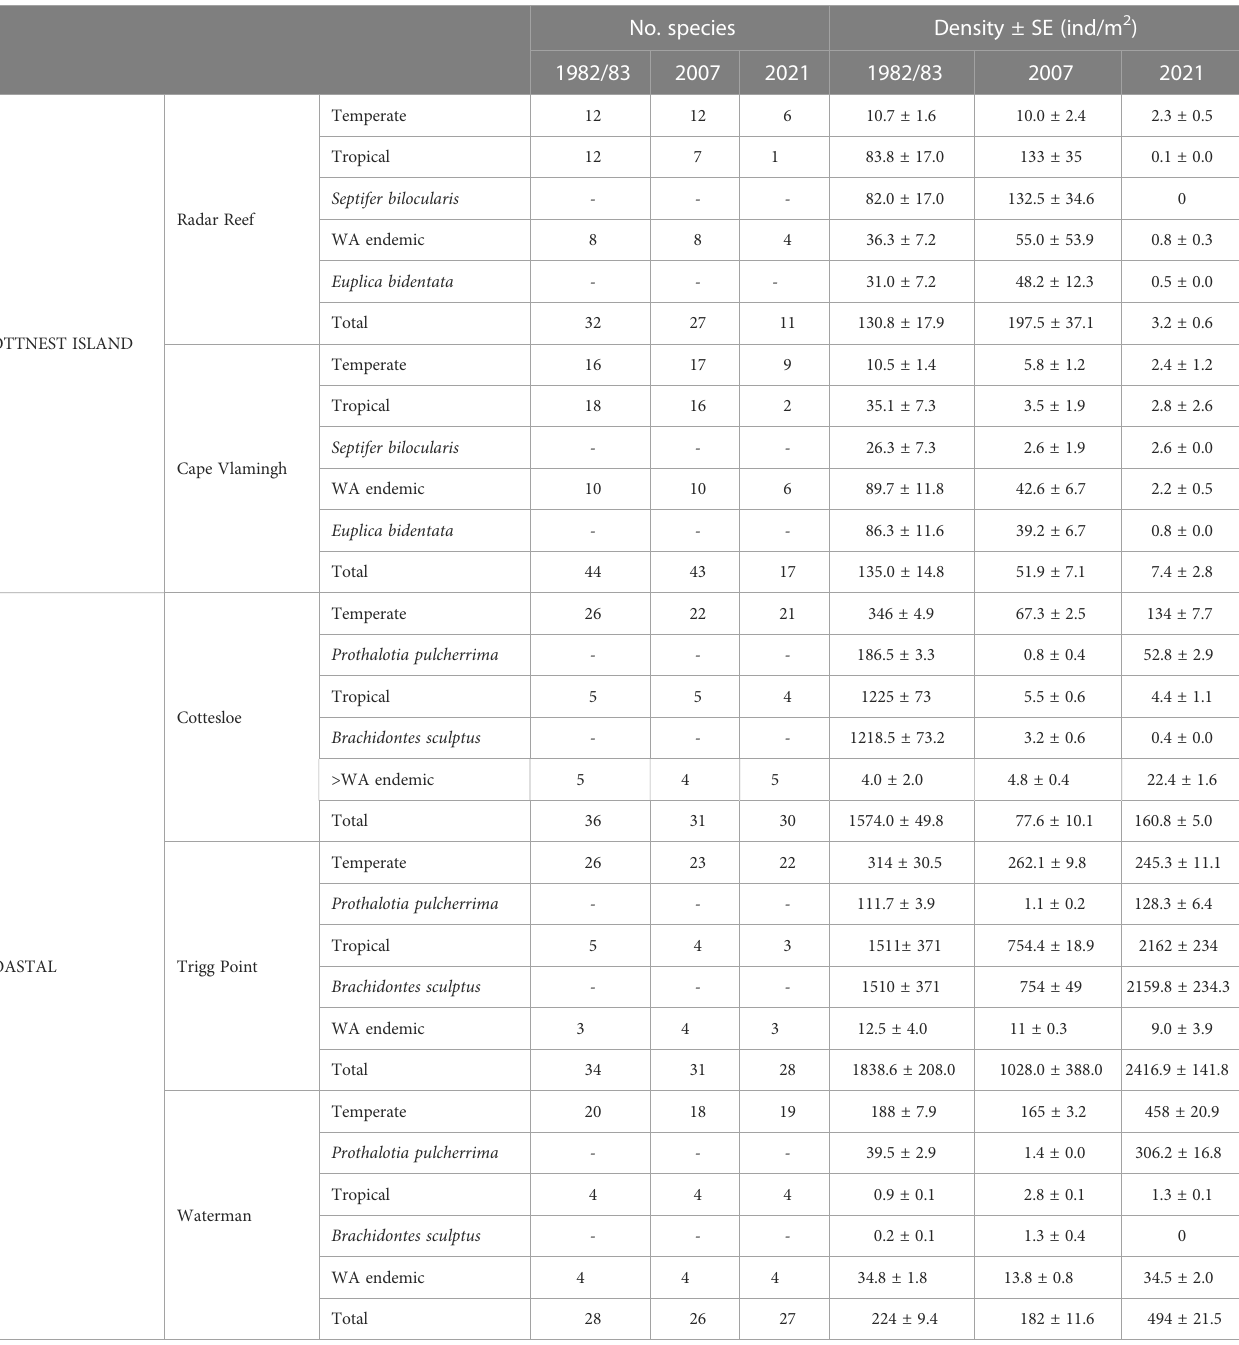
TABLE 1 Distribution patterns of mollusc species identi fi ed on intertidal platforms at Rottnest Island and the Perth coastline, Western Australia.